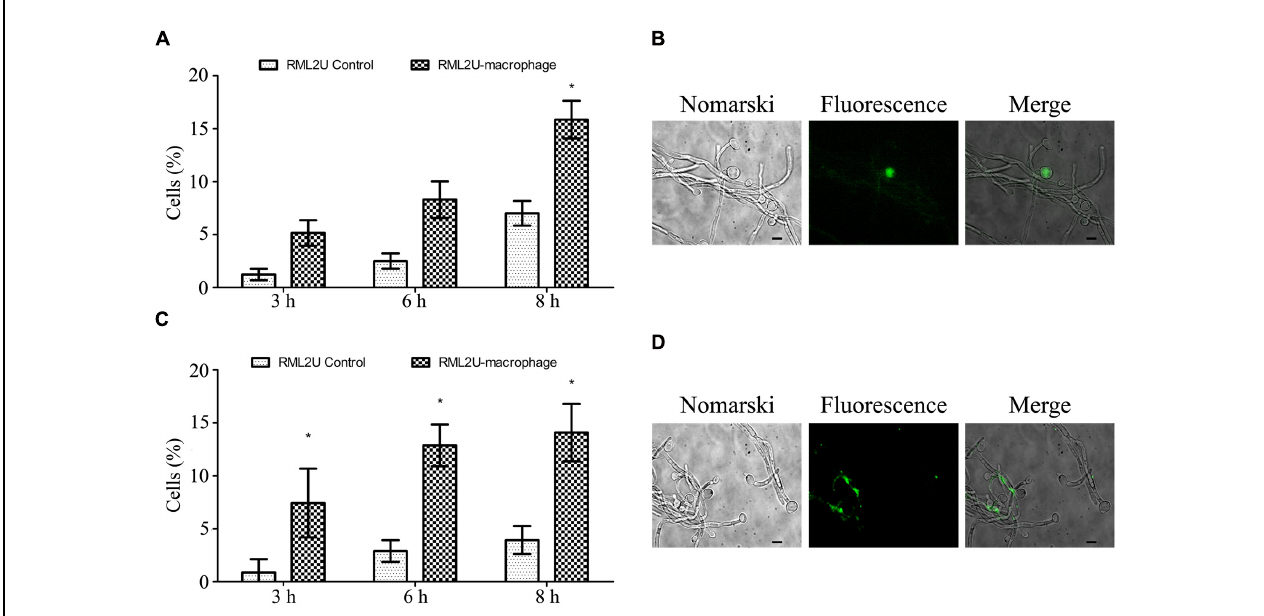
FIGURE 8 | Measurement of the apoptotic status of C. albicans strains after the interaction with murine macrophages. (A) Percentage of C. albicans cells that contain ROS after 3, 6, and 8 h of macrophage interaction. (B) Representative fluorescence images of C. albicans culture stained with DHR 123. (C) Percentage of C. albicans cells with active caspase revealed by the caspase inhibitor VAD-FMK-FITC. (D) Representative fluorescence micrographs showing caspase activity in C. albicans cells. Statistically significant differences relative to the RML2U control are indicated ( ∗ p <